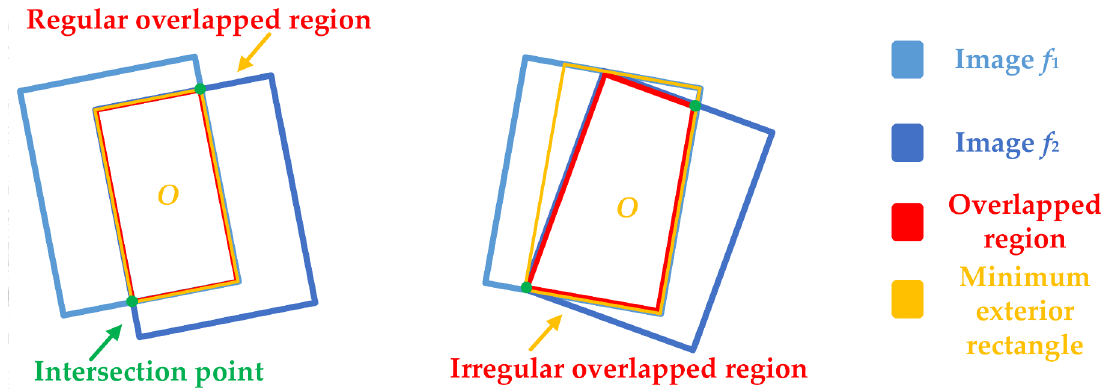
Figure 5. Processing principle of irregular overlapped region: ( a ) Regular overlapped region; ( b ) Irregular overlapped